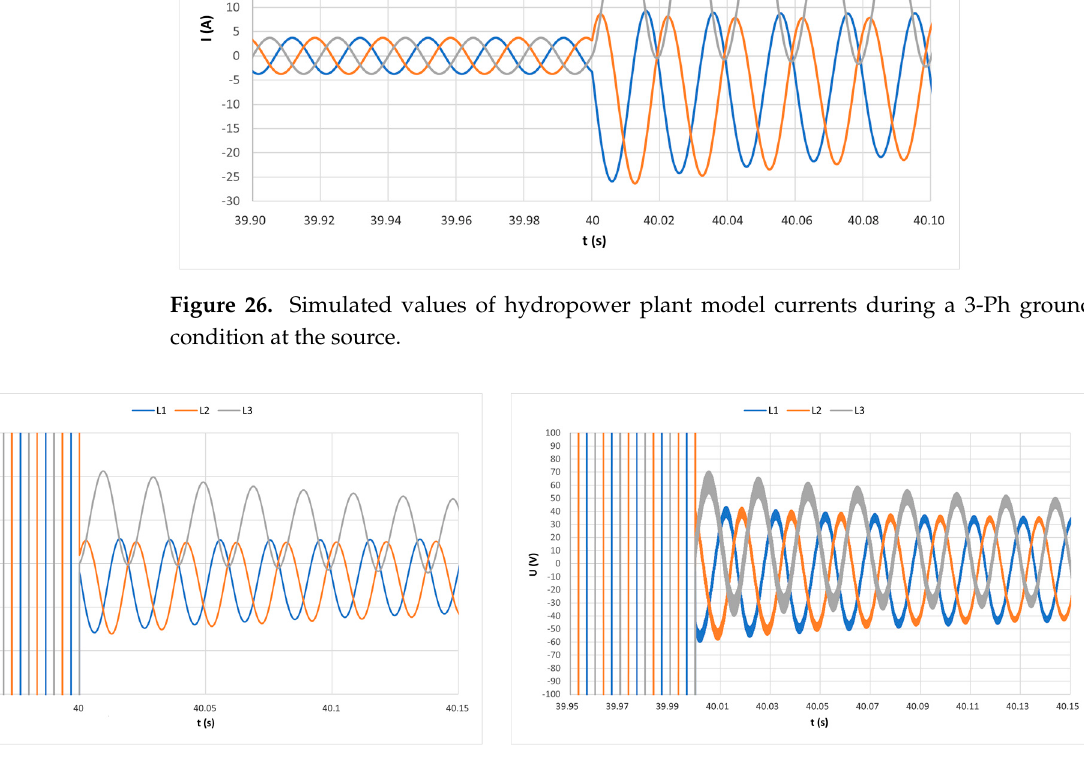
Figure 26. Simulated values of hydropower plant model currents during a 3-Ph ground fault con- dition at the source.